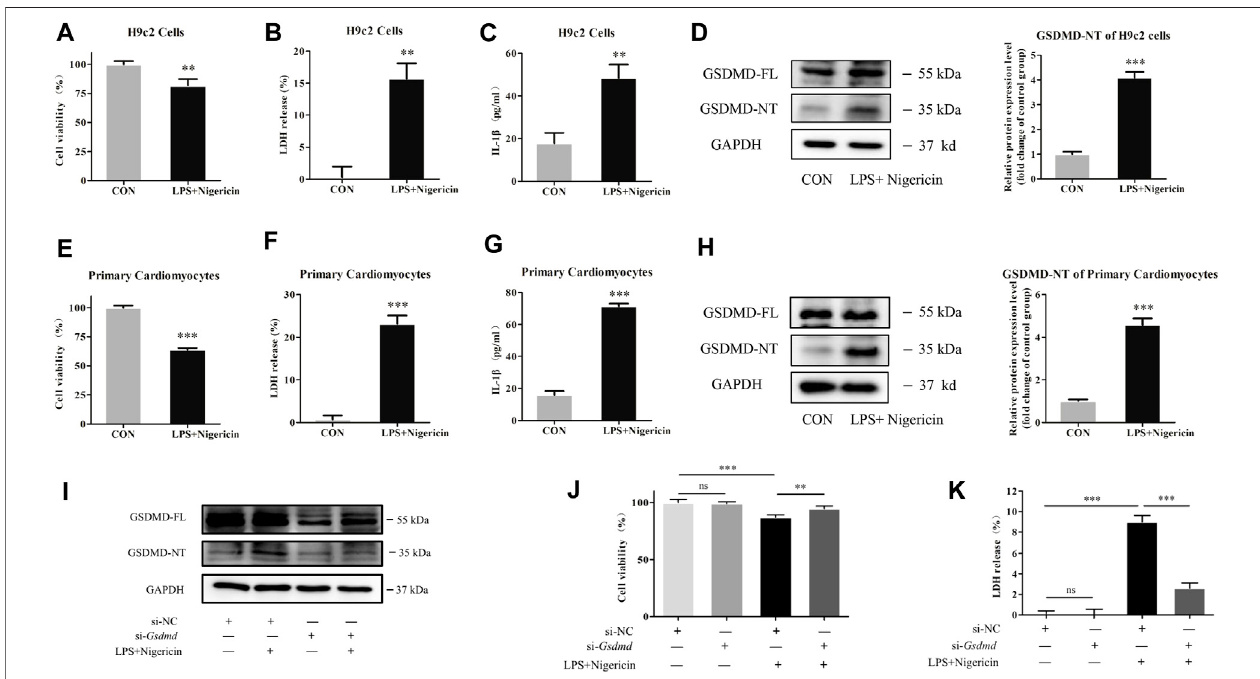
FIGURE 4 | GSDMD silencing alleviated myocardial cell injury induced by LPS. (A and E) CCK-8 assay was applied to measure cell viability of each group. (B and F) LDH releaseinsupernatantsofeach group. (Cand G) Thelevel ofIL-1 β insupernatantsofeachgroup. (Dand H) Expressions ofGSDMD and GSDMD-NT protein in H9c2 cells andprimary cardiomyocytes weremeasuredbyWestern blottinganalysis.The resultswere normalized totheexpression ofGAPDH.Thedata areexpressed as the mean ± SD (n (cid:1) 3). (I) After transfected with siRNA of Gsdmd , H9c2 cells were treated with LPS plus nigericin to establish the myocardial injury model. Expressions ofGSDMD and GSDMD-NT protein inH9c2 cellsweremeasured byWesternblotting analysis(n (cid:1) 3). (J) CCK-8assay wasapplied to measure cell viability of each group. (K) LDH release in supernatants of each group. The data are expressed as the mean ± SD (n (cid:1) 3). ** p < 0.01, *** p < 0.001.